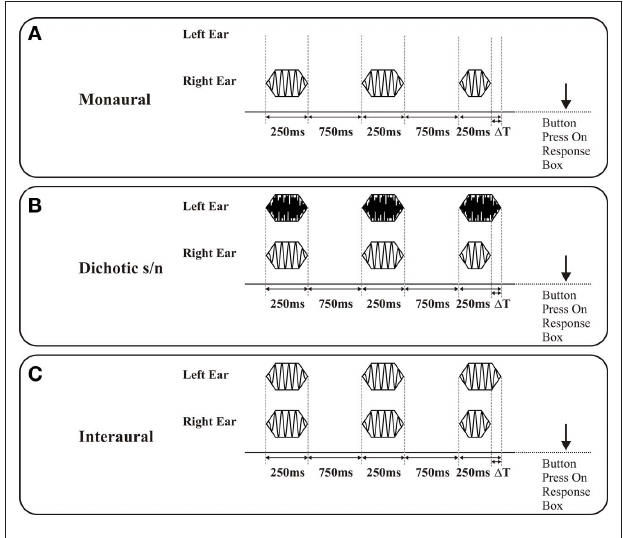
FIgure 1 | Depiction of signal presentation on discrimination of differences in signal duration (signal duration 250 ms; interstimulus interval 750 ms): The duration of the deviant is shorter than the reference signals and systematically prolonged ( ∆ T) starting with an initial value of ∆ 120 ms, the position of the deviant in the triplet is randomized in successive presentations. The subject is asked to indicate the position of the deviant signal in the stimulus triplet by pressing a button on a response box. (A) Monaural presentation: Signals are presented either to the right or the left ear; the graph shows a signal triplet presented to the right ear. (B) Dichotic signal/noise presentation: Signal triplets are presented either to the right or the left ear (in the present example to the right ear). A triplet of noise bursts are concurrently presented to the respective other ear (in the present example to the left ear, noise burst duration 250 ms). (C) Interaural presentation: For the reference condition, the signals presented to both ears were identical in frequency. The deviant signal on the right ear coincides with a standard signal on the left ear. In the case of duration discrimination a movement of the